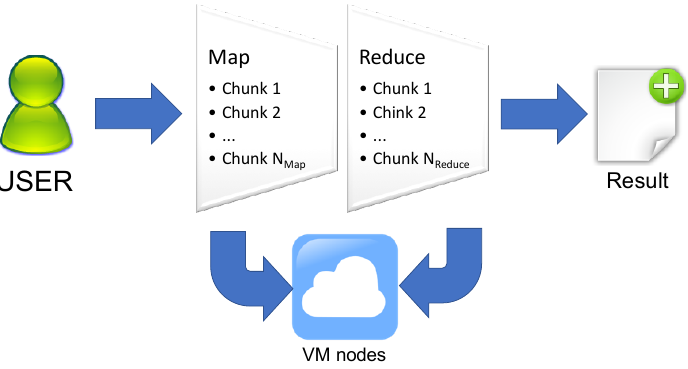
Figure 9. A MapReduce application deployed on the